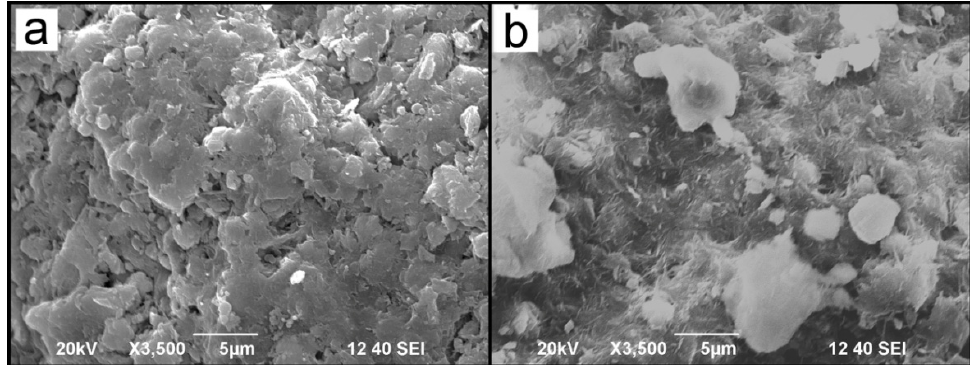
Figure 3. Scanning electron microscope ( SEM) images of natural ATP ( a ) and CM-ATP ( b ).